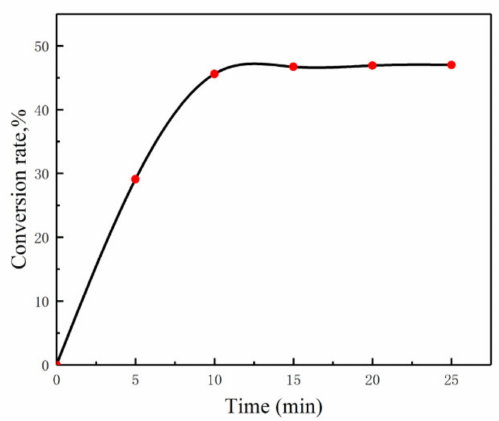
Figure 6. Evolution of the conversion rate of ammonium chloride over time at an initial pH of